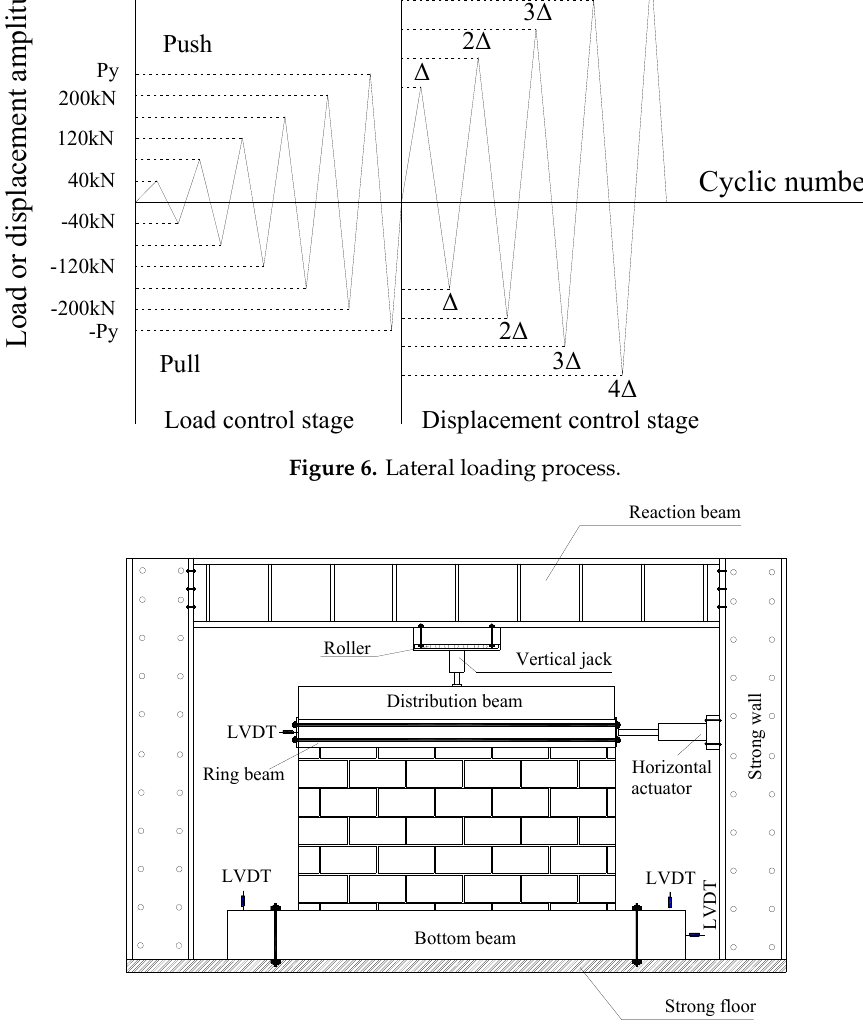
Figure 6. Lateral loading process.